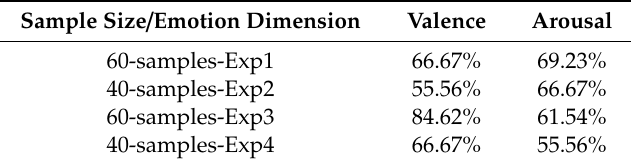
Table 3. Comparison of all experiments’ results.